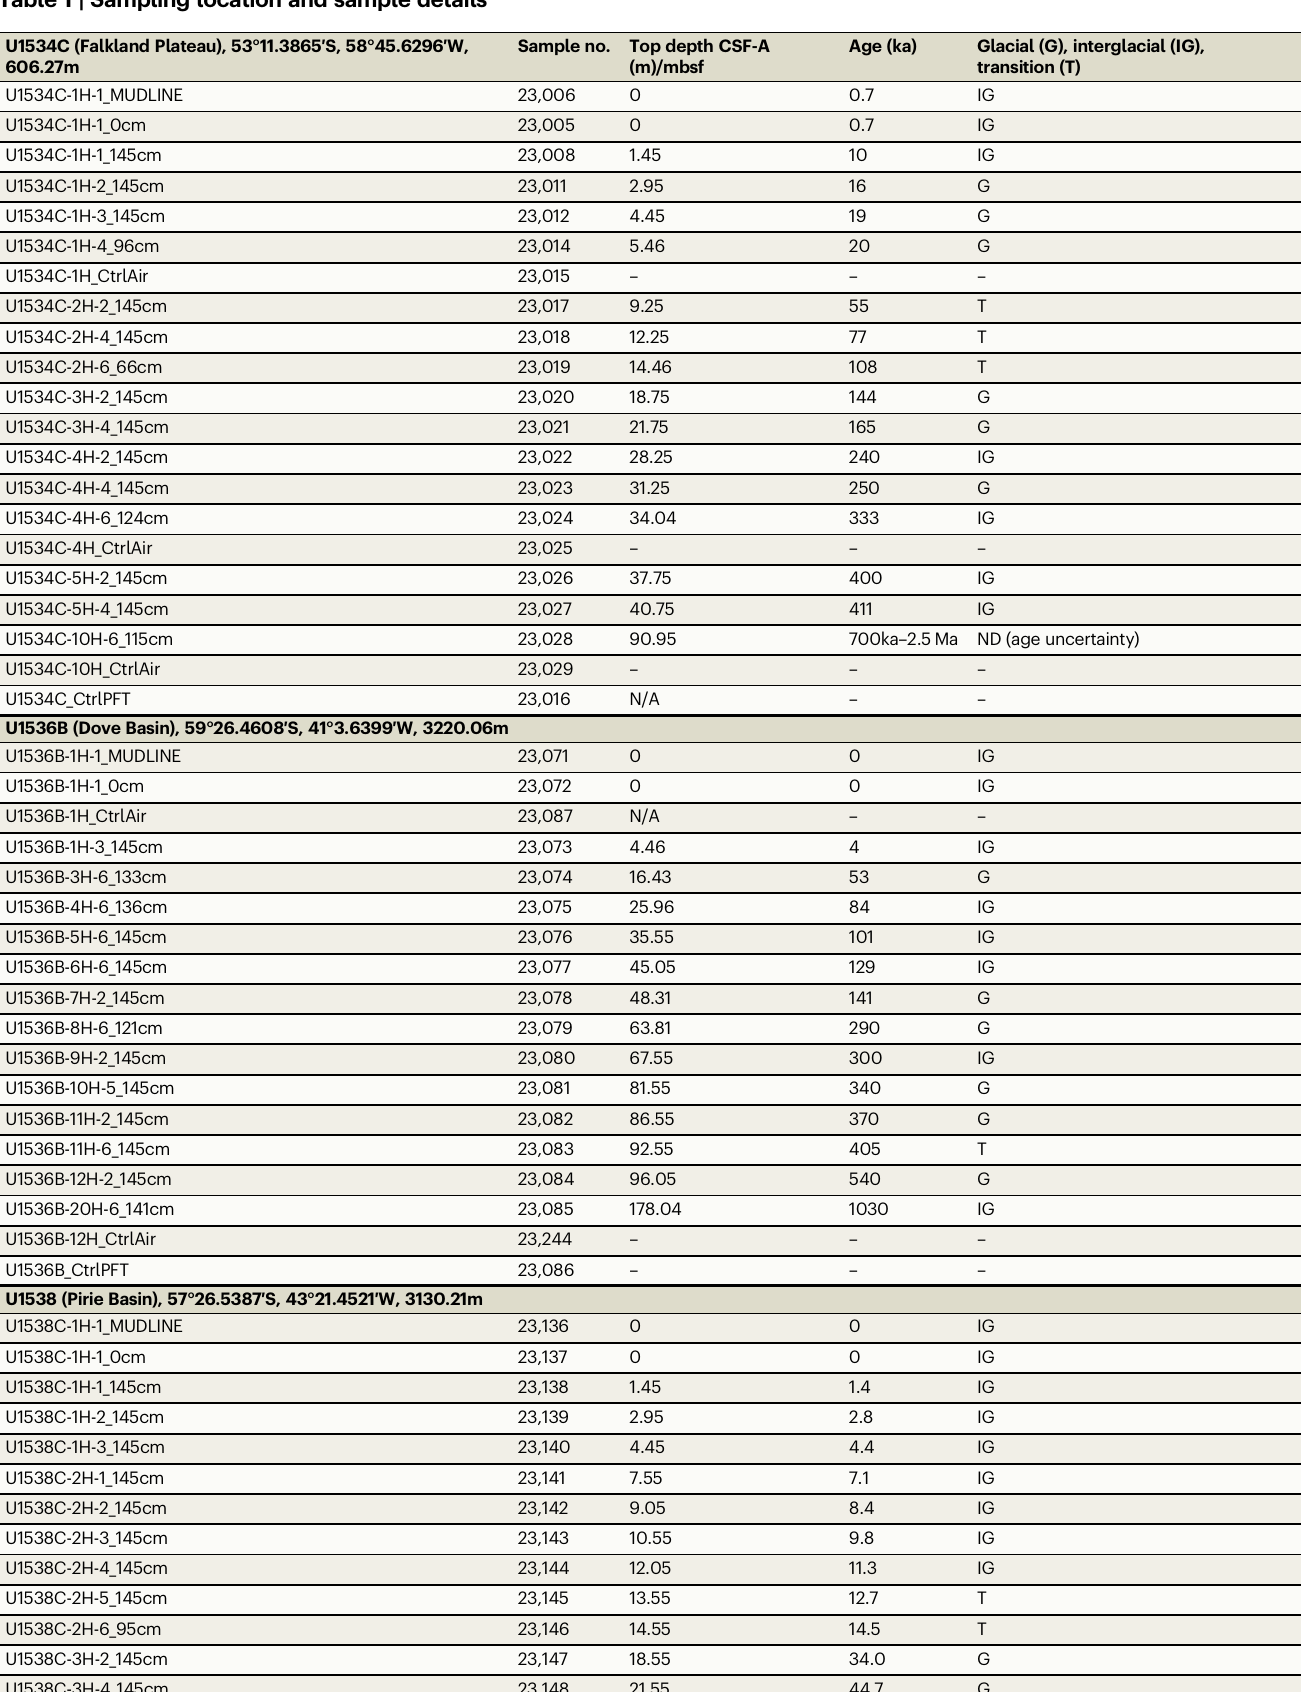
Table 1 | Sampling location and sample